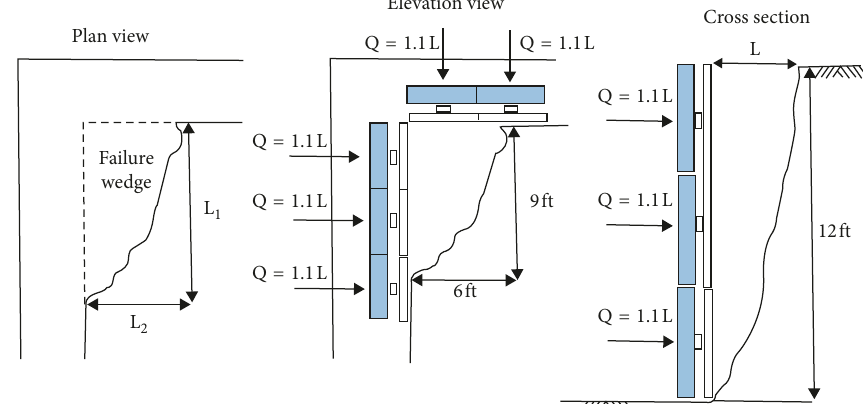
Figure 4: Scenario 2: failure geometry and emergency rescue shoring layout. Note that the panel placement shown is not ideal for actual rescue operations but demonstrates minimum necessary